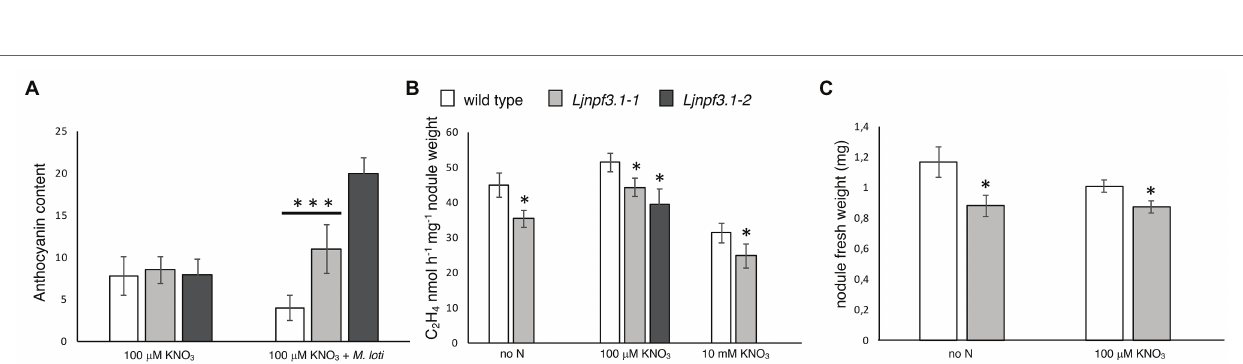
FIGURE 6 | Phenotypic characterization of Ljnpf3.1-1 and Ljnpf3.1-2 mutants. (A) Analysis of anthocyanin content in the stems of wild-type and Ljnpf3.1 plants grown in Petri dishes with/without M. loti inoculation. Relative anthocyanin levels scored in the Y -axis were determined with the equation OD 530 – (0.25 × OD 657 ) × extraction volume (ml) × 1/weight of tissue sample (g) = relative units of anthocyanin/g fresh weight of tissue. Anthocyanin was extracted 4 weeks after sowing. (B) Acetylene reduction activity (ARA) per nodule weight at 4 weeks postinoculation. (C) Nodules fresh weight. Plants were grown in Petri dishes as in Figures 5A – C . N regimes and plant genotypes are indicated. Data bars represent the means and SE of measures from six experiments in ( B ; eight samples of five nodules per experiment per condition). Asterisks indicate significant differences with wild-type levels. ∗ p < 0.05 and ∗∗∗ p <